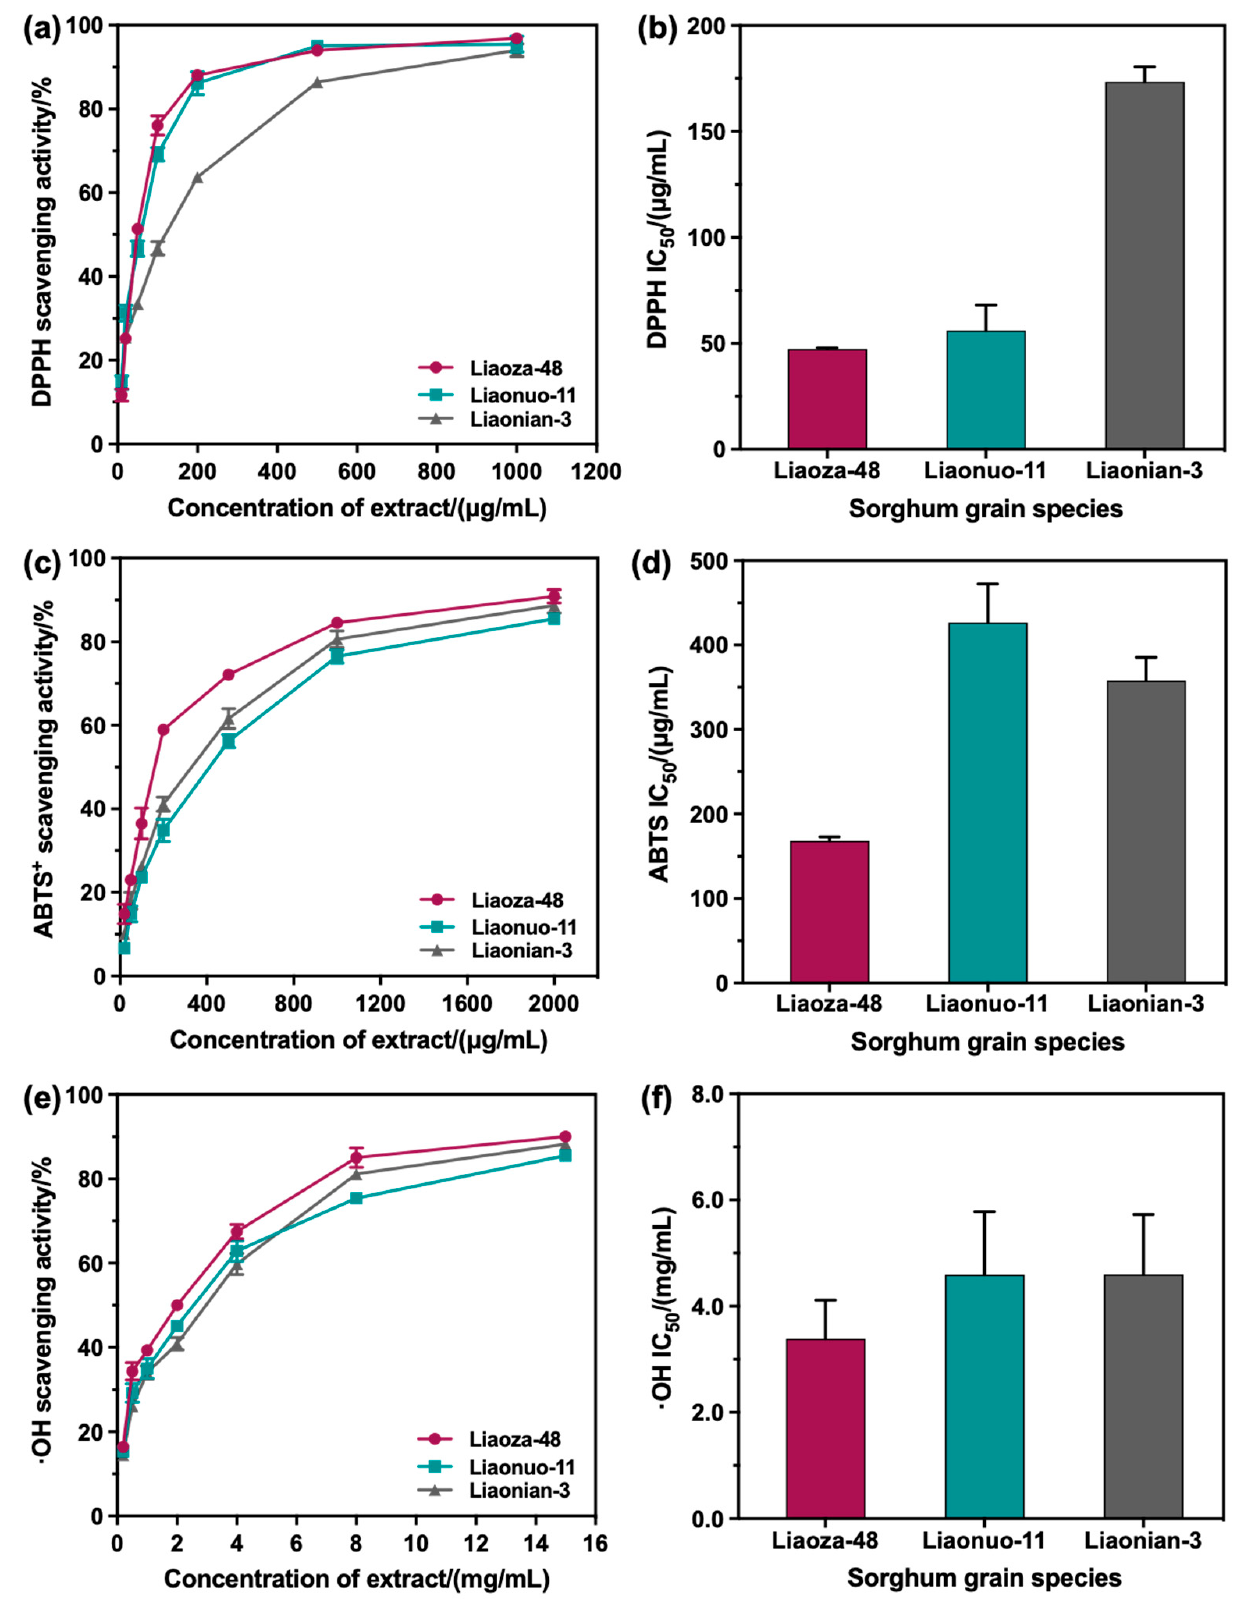
Figure 7. The free-radical scavenging activity of 3-DAs in three sorghums (( a ): DPPH; ( c ): ABTS + ;